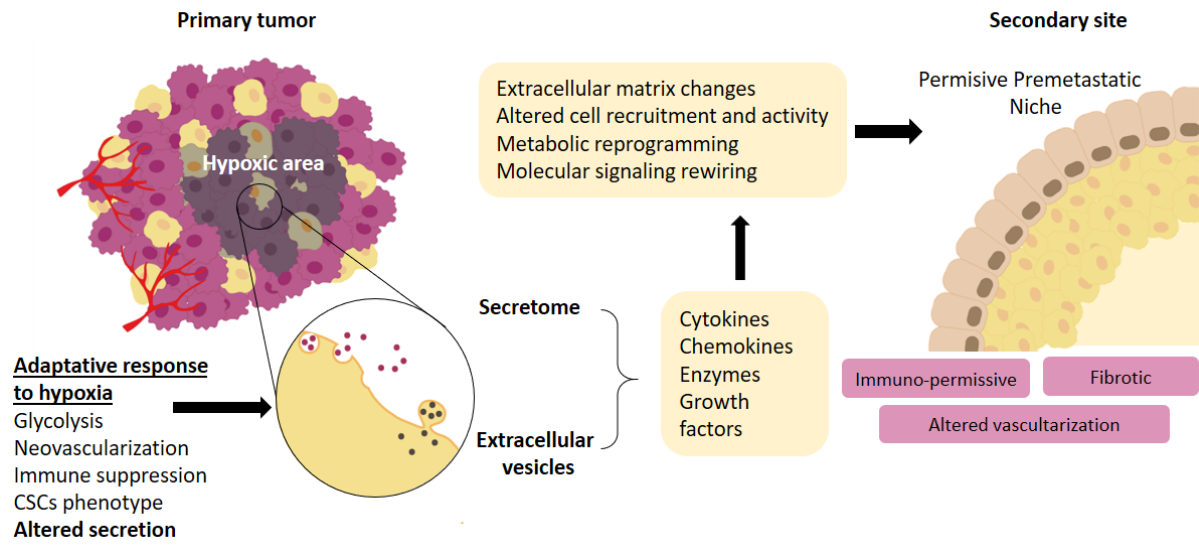
Figure 1. Schematic summary. As part of the adaptative response to hypoxic conditions, both tumoral and stromal cells alter the secretion of free molecules and extracellular vesicles, which upon arrival at the secondary site promote a series of changes that result in a permissive premetastatic niche . Table 1. Summary of the role of several hypoxia-induced molecules in the generation of the premetastatic niche.